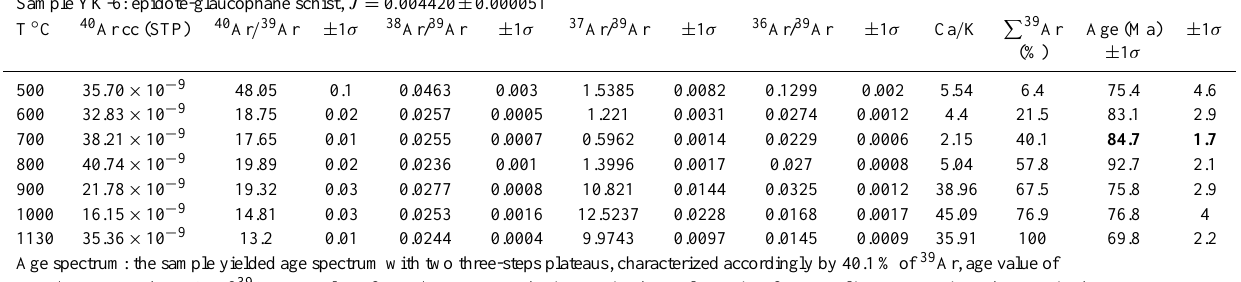
Age spectrum: the sample yielded age spectrum with two three-steps plateaus, characterized accordingly by 40.1% of 39 Ar, age value of 83 . 5 ± 1 . 7Ma and 42.2% of 39 Ar, age value of 72 . 2 ± 2 . 2Ma. On the inverse isochron plot, points form two linear regressions characterized by age value of 87 . 8 ± 2 . 5 and ( 40 Ar/ 36 Ar) 0 = 285 ± 5, respectively. The presence of two age plateaus evidence to isotope heterogeneity of YK 6.